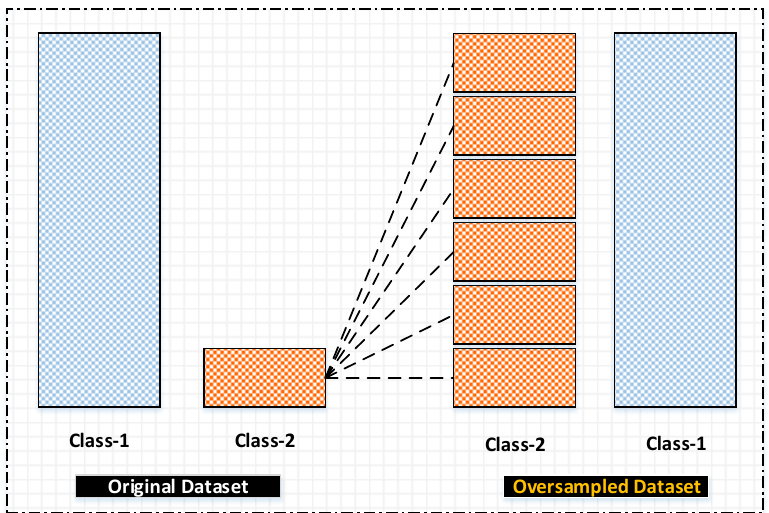
Figure 1. Oversampling technique of the two classes to enlarge the minority class.